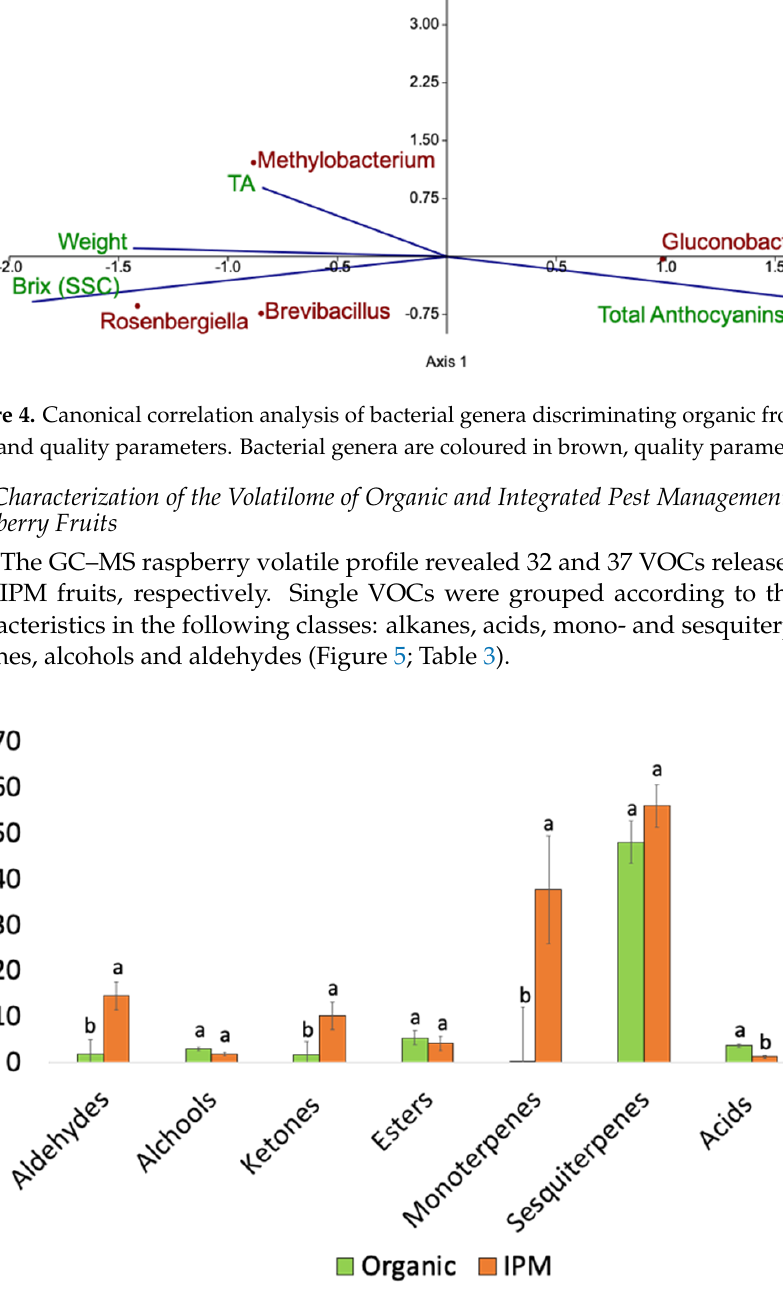
Figure 5. Abundance of volatile organic compound classes are showed for organic and IPM grown raspberry fruits ‘Enrosadira’. Bars represent the mean ± SE. Different letter indicate significant differences between cultivation methods according to Student’s t -test at p -value < 0.05. Table 3. Volatile organic compounds emitted by raspberry fruit ‘Enrosadira’ cultivated with organic (Org) or integrated (IPM) practices. Data are reported as mean ± SE. Values labelled with different letters indicates significant differences between the cultivation methods according to Student’s t -test at p -value < 0.05. nd = not detected.